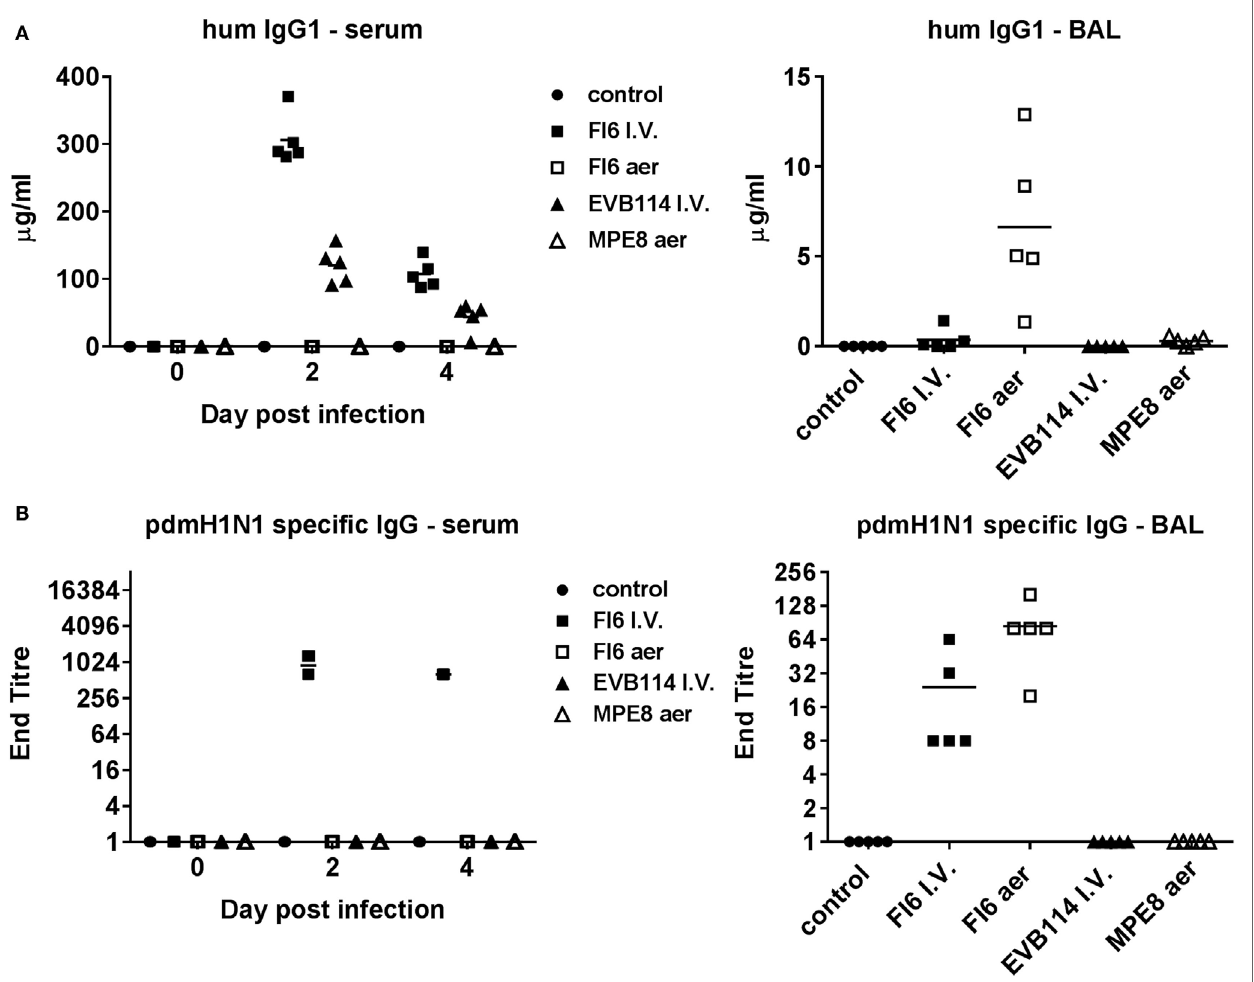
FigUre 3 | Mucosal and systemic IgG responses following administration of antibodies. Human IgG1 (a) and pdmH1N1-specific IgG (B) titers in serum at 0, 2, and 4 day post infection (dpi) and in broncho-alveolar lavage at 4 dpi. Note for pdmH1N1-specific antibody in serum—all five pigs had titers of 1:640 at 4 dpi, while two animals at 1:1,024, and three at 1:640 at 2